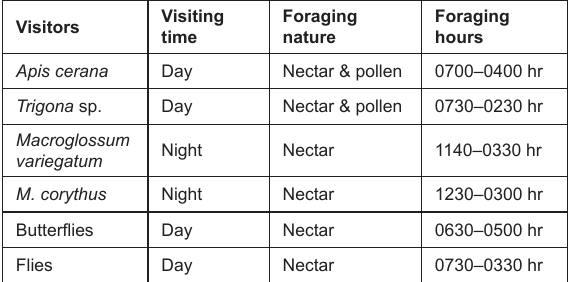
Table 3. Pollinators and their characteristics in Impatiens